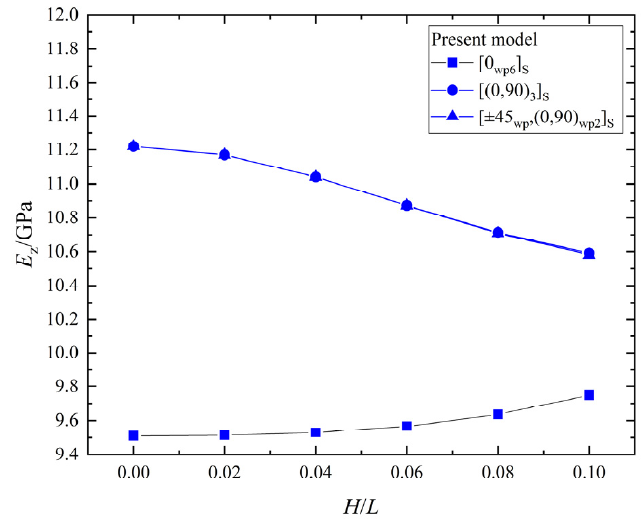
Figure 13. The effective elastic stiffness, E z , vs. wrinkle parameter, H/L , in laminates.